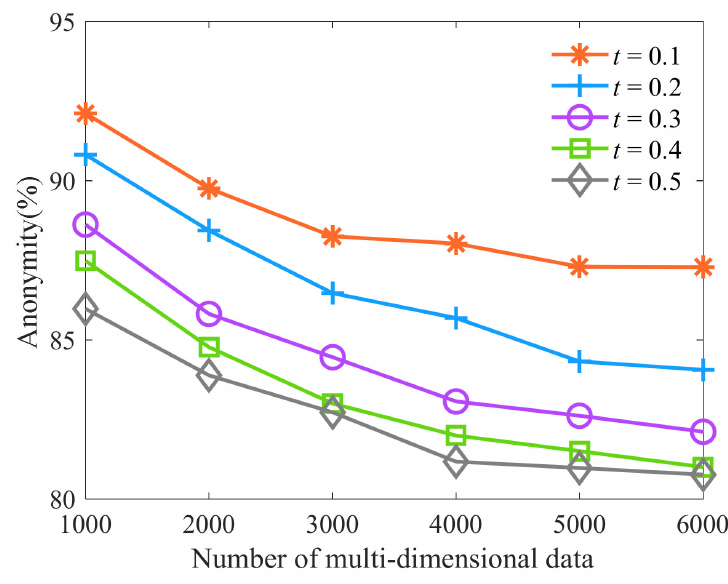
Figure 4. Algorithm anonymity of different constraint parameters t